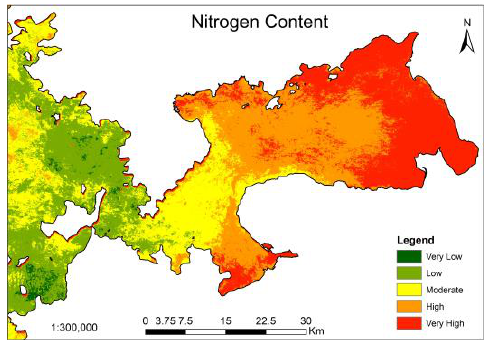
Figure 8: Correlated the presence of nitrogen uptake in water The above map shows the areas around the shores of Winum gulf, having a high nitrogen content. Green Normalised Difference Vegetation Index (GNDVI) is tidally correlated to the amount of nitrogen content, which is used to map the nitrogen content in Lake Victoria.